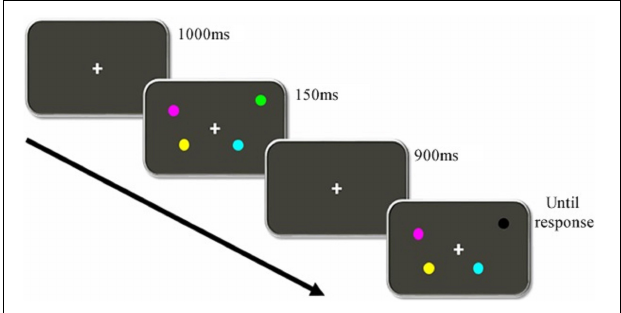
FIGURE 1 | Sequence of events for a Change Location Task trial. Participants needed to identify the circle that changed colors between